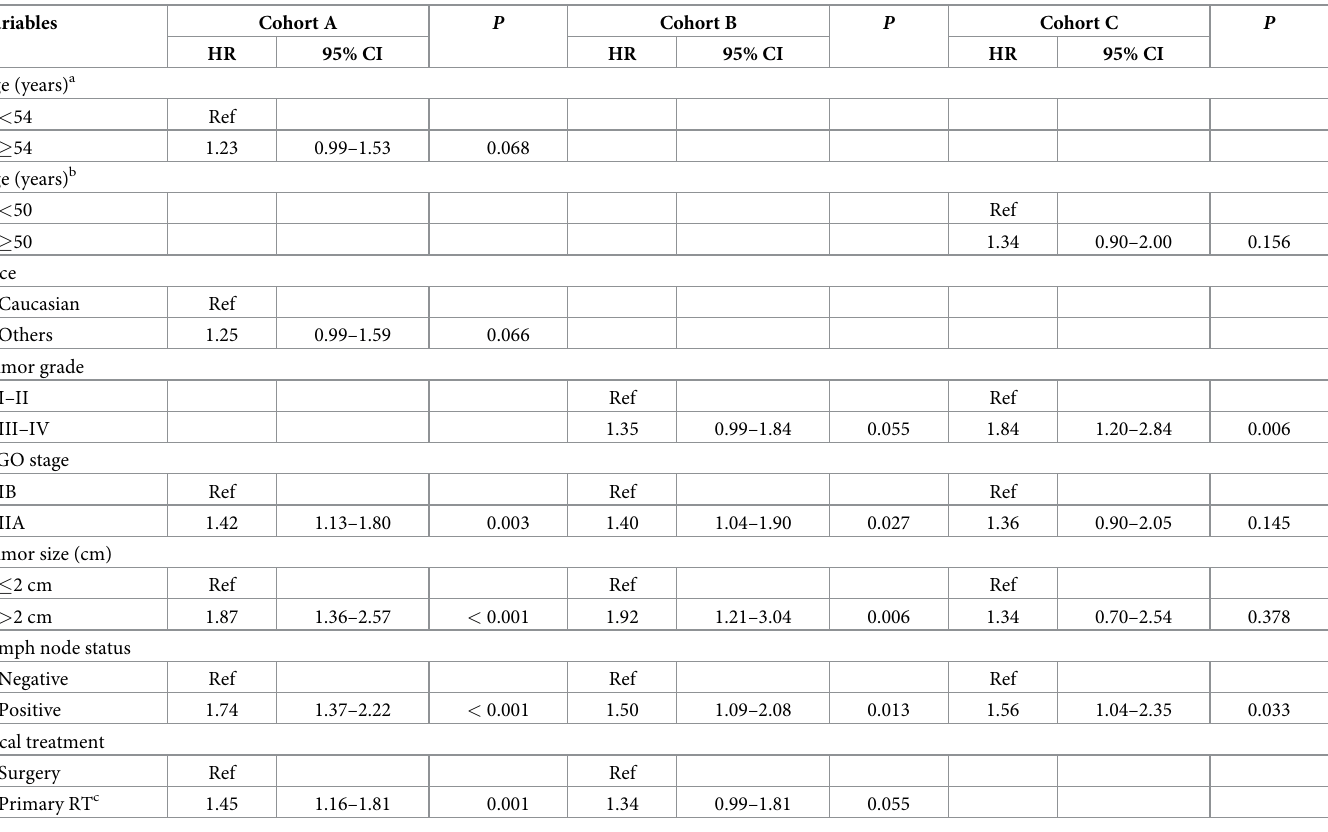
Table 3. Prognostic factors associated with disease-specific